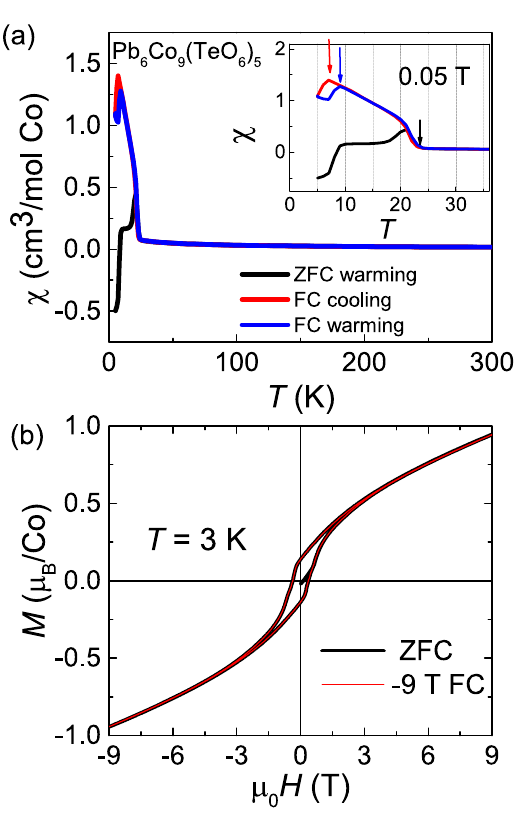
Figure 6. ( a ) χ ( T ) measured at 0.05 T on the polycrystalline samples of Pb 6 Co 9 (TeO 6 ) 5 . Inset shows the magnetic transitions at low- T . ( b ) M ( H ) at 3 K after ZFC and − 9 T